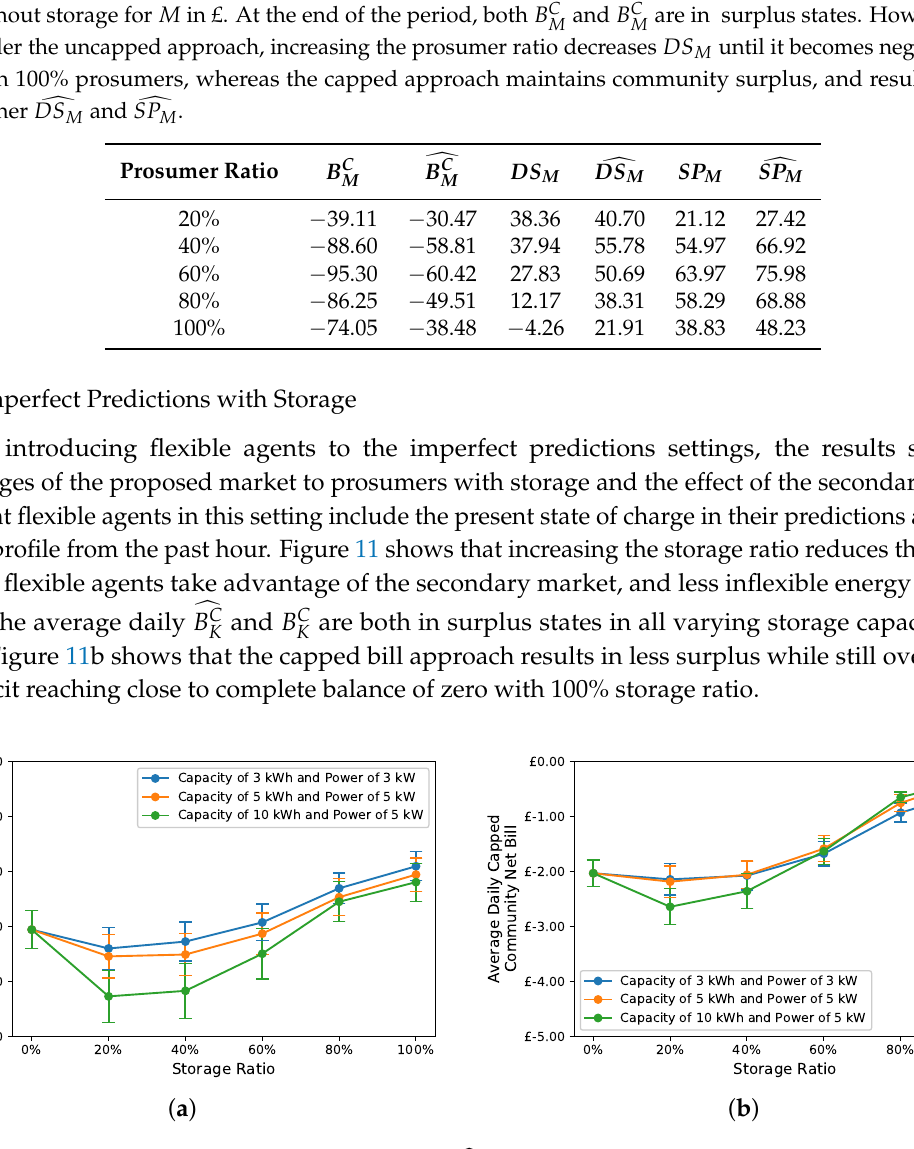
and (cid:100) B C are in surplus states. However, M M